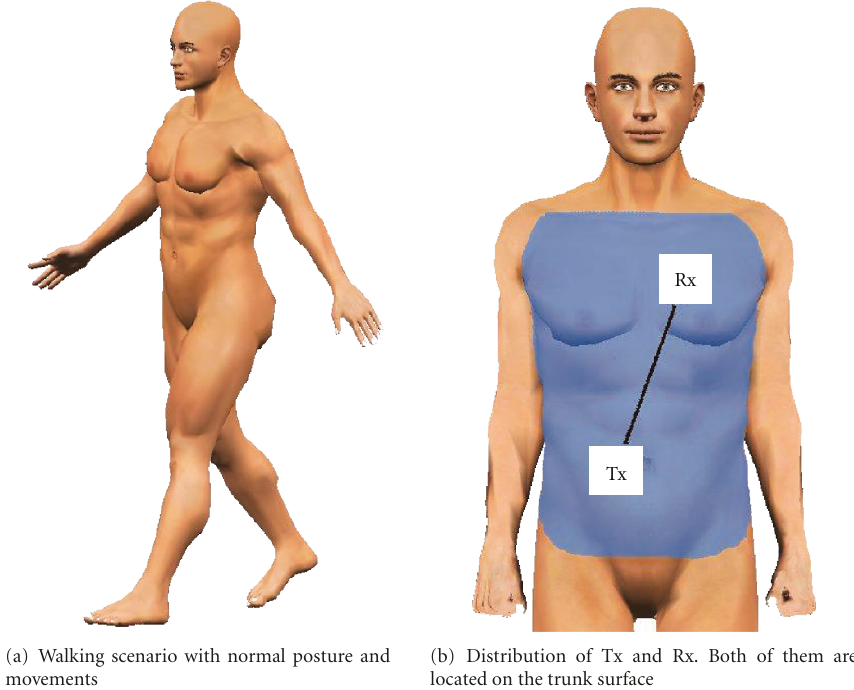
Figure 1: The investigated on-body propagation scenario on a walking